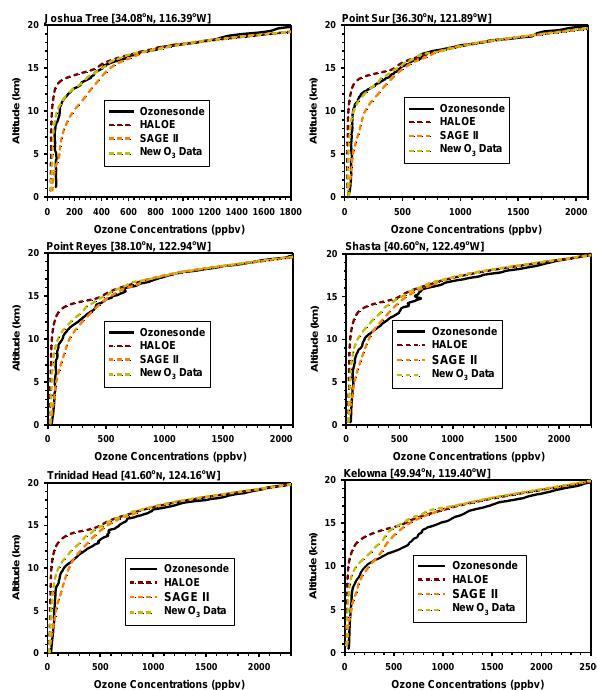
Fig. 16. Modeled ozone profiles compared with measurements at six ozonesonde sites during the 2010 CalNex field study, using data from HALOE, SAGE II and this new ozone climatology, respectively, as upper boundary conditions.